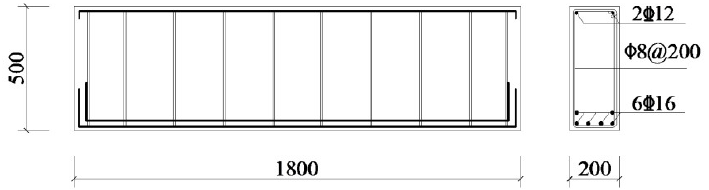
Figure 4. Cross-sectional view of the DSRC deep beam for stirrup rate ρ v = 0.252%. Table 5. Details of test beams.